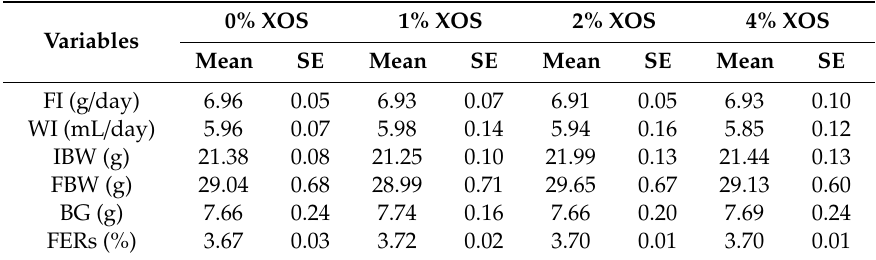
Table 1. Weight Gain, Food and Water Intake, and FER of all mice fed different levels of XOS (Mean values and standard errors; n = 8 in each